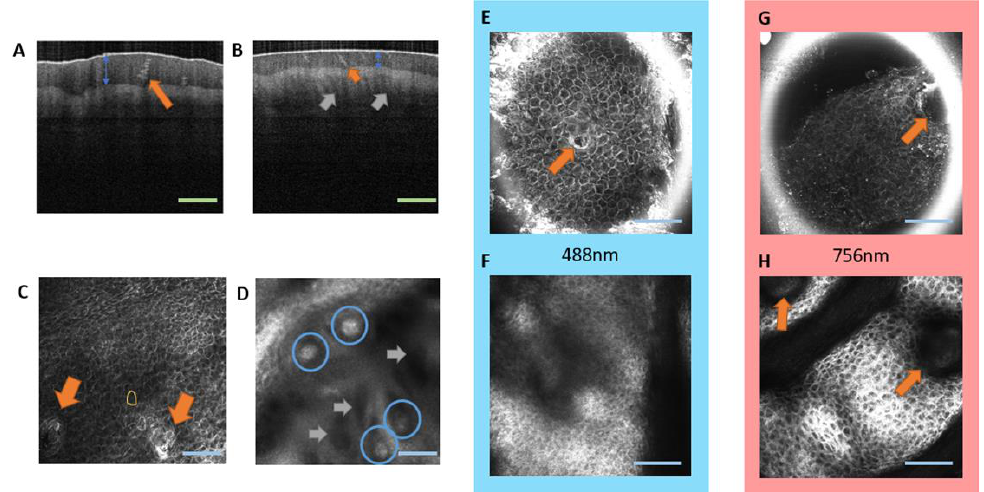
Figure 1. Comparison of imaging techniques for the glabrous skin. Longitudinal cross-sections recorded by OCT allow for the quantification of the SC thickness (blue arrows) for the index finger ( A ) and the small finger ( B ) of one participant, green scale bar 200µm. Sweat glands (orange arrow) appear as helicoidal structures. Papillary structures are observed only in the small finger ( B , gray arrows) due to the thinner SC. LSM images of the small finger recorded at 70 µm ( C ) and 240 µm ( D ) depth exhibit corneocytes ( C , yellow contour) and the sweat glands ( C , orange arrows), MCs at the DEJ ( D , blue circles) as ellipses with high reflectance, and the papillae ( D , gray arrows). LSM images recorded with the 488 nm laser have a better resolution for the SC at a depth of 20 to 70 µm ( E ) than the 756 nm laser ( G ), while the larger penetration depth of the 756 nm laser provides more detail in the epidermis and at the DEJ at a depth of 150 to 250 µm ( H ) compared to the 488 nm laser ( F ). Orange arrow indicate sweat glands, blue scale bar: 100µm